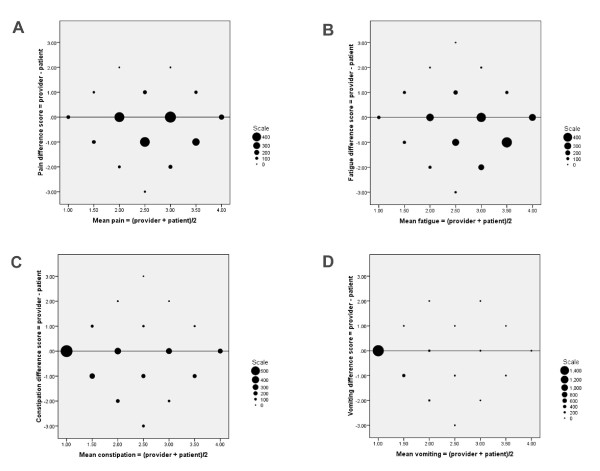
Bland-Altman plots, one for each symptom (see also Figure 2). The difference between patient and provider score (difference score = health care provider score minus patient score) plotted against mean symptom score. The size of markers reflect the number of individual observations and only the line of equality (difference = 0) is shown. Negative differences mean that providers underestimated the symptom. The larger the size of the markers at one side of the line of equality, the larger was the tendency of a systematic difference between assessments (i.e. more observations below the line suggest that providers had a negative bias and underestimated symptom intensity). Whether differences between provider and patient assessments changes with the mean value of symptom intensity is determined by looking for patterns along the x-axis. (A): Pain. (B): Fatigue. (C): Constipation. (D): Vomiting.